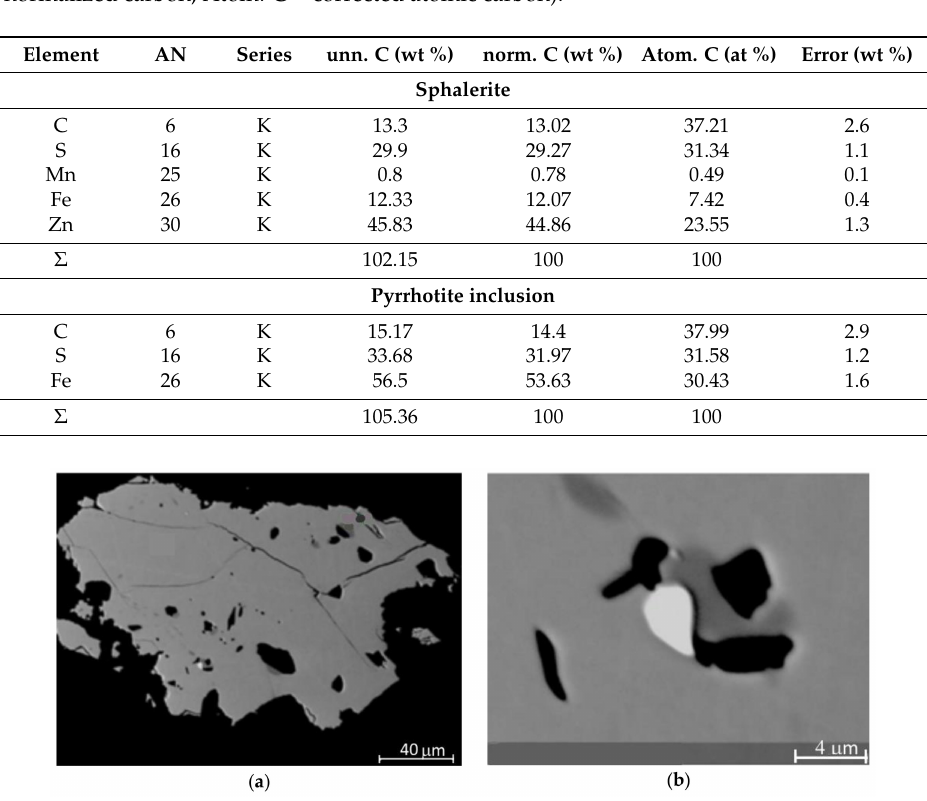
Table 5. Chemical composition of sphalerite with a pyrrothite inclusion in wt %/at % of sample B1-J (AN = atomic number, series = emitted X-ray series, unn. C = non corrected carbon, norm. C = normalized carbon, Atom. C = corrected atomic carbon).